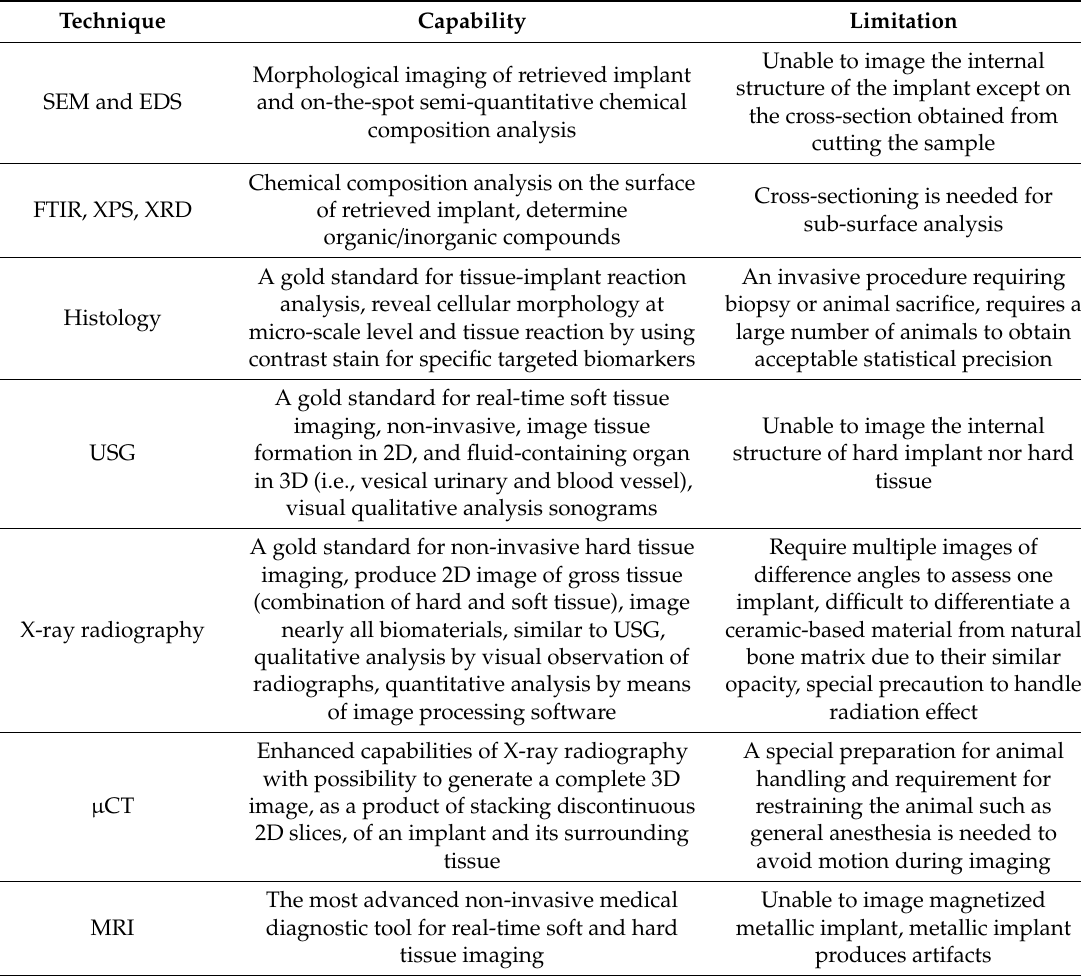
Table 2. Comparison of capabilities and limitations of common techniques for in-vivo corrosion assessment of absorbable metal